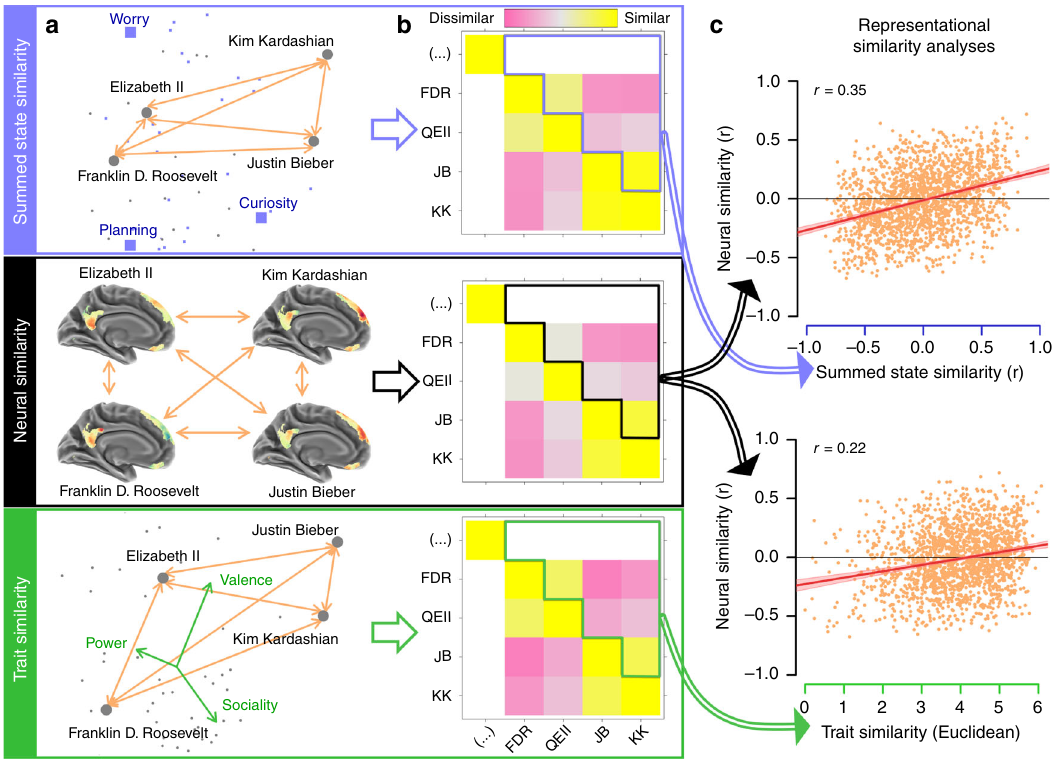
Fig. 2 Comparing the summed state and trait accounts of person perception. a For each target, state frequencies (purple), neural pattern similarity (black), and trait ratings (green) were converted into the common metric of interpersonal similarity ( b ). Orange arrows indicate similarities measured in each respective space. Arrows from a to b represent the extraction of similarities from each measure. c The summed state similarities (top) were more strongly correlated with neural similarity than trait similarity (bottom). Arrows from b to c indicate which similarities map onto which scatter plot axes. These fi ndings replicated using other similarity measures — ratings, choices, reaction times, and text — suggesting that summed states provide a better account of person perception. The shaded regions in the scatterplots represent 95% con fi dence intervals around the best fi t